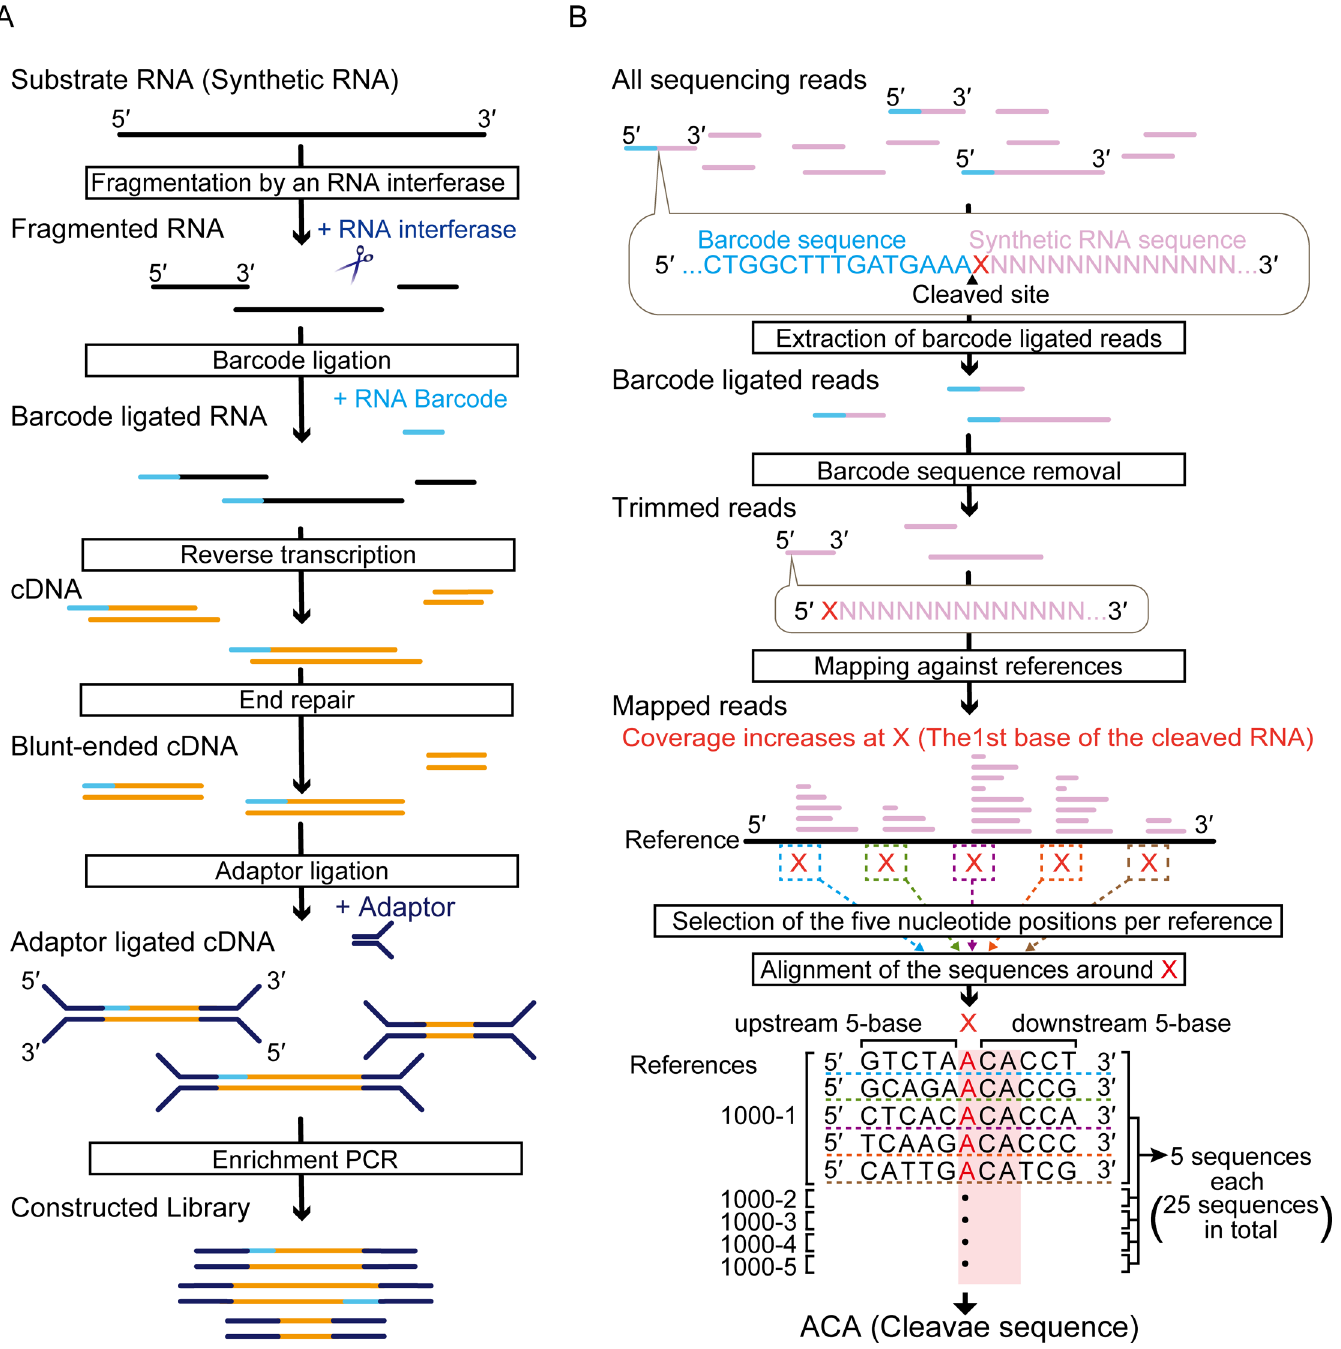
Fig 1. Schematic representation of the experimental methods. (A) Overview of the sequence library construction method. (B) Workflow for identification of RNA cleavage site (see